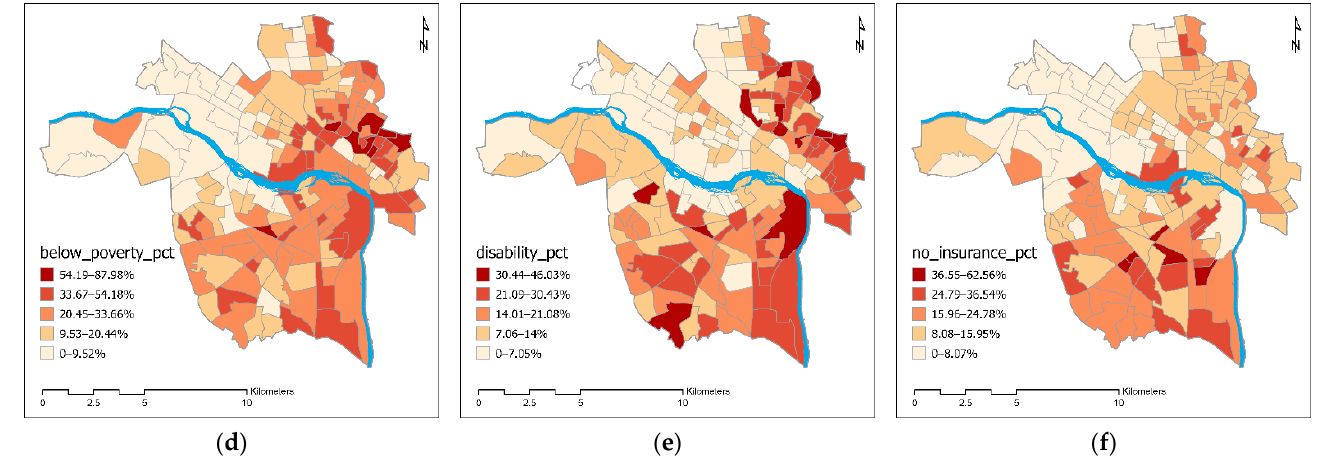
Figure 4. City of Richmond ambient temperature and vulnerable populations at the Block Group level: ( a ) mean ambient temperature; ( b ) percentage of older adults 65 years and over; ( c ) percentage of non-white population; ( d ) percentage of population with income below poverty level; ( e ) percentage of population 20–64 years with a disability; ( f ) percentage of population with no health insurance coverage.